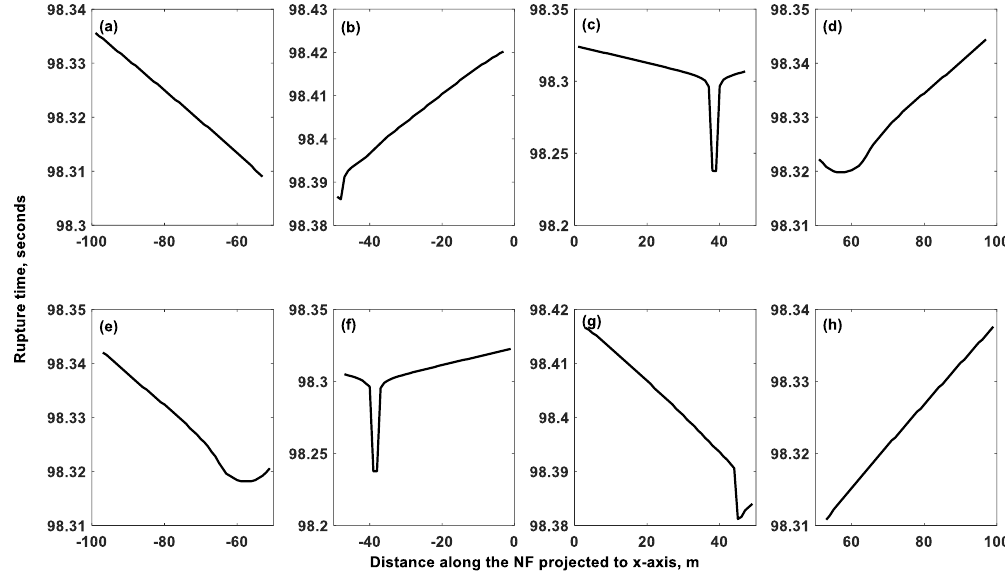
Figure 5—Rupture along the NFs in Model B (i.e., cohesion = 0.35 MPa).